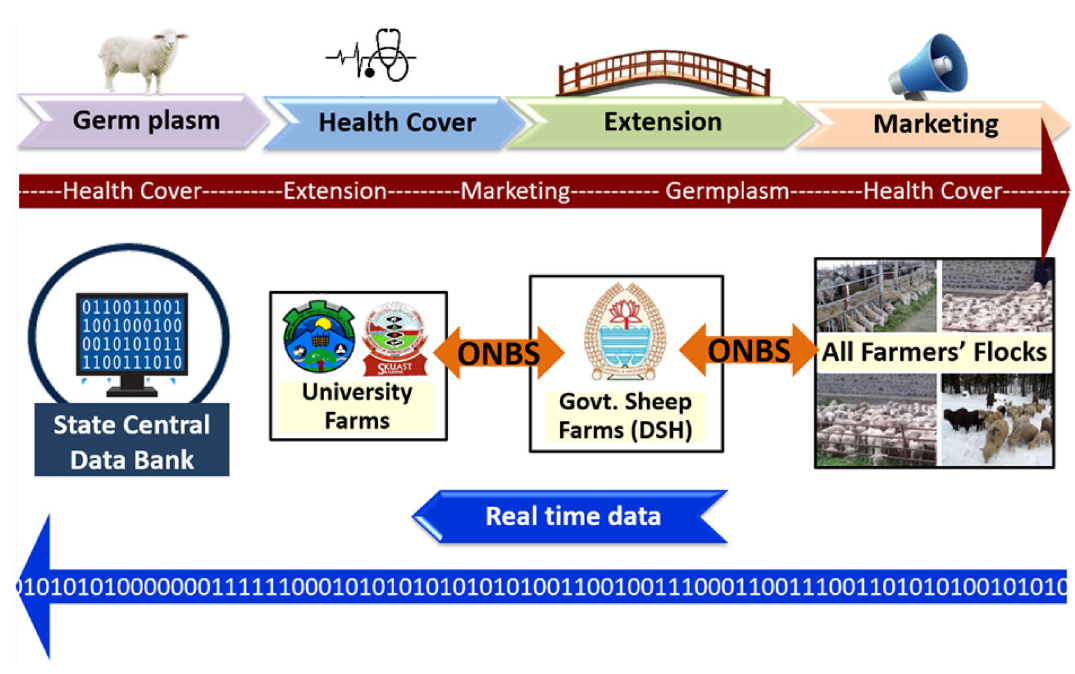
Figure 3. Smart Sheep Breeder for ONBS and data